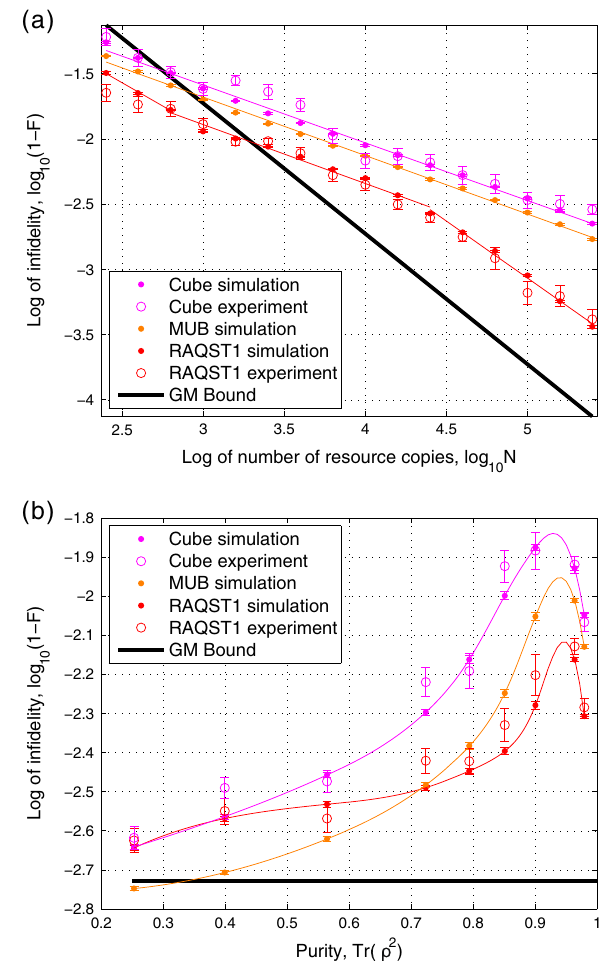
Fig. 4 Experimental results. a In fi delity vs. N . Dots are the average in fi delity of simulation results with 1000 repetitive runs of RAQST1 ( red ), MUB ( khaki ) and standard cube measurements ( magenta ), and circles are the corresponding average in fi delity of 10 repetitive experimental results. Error bars are the standard deviation of the average. b In fi delity with respect to purity for N = 10 4 . Simulation ( dots ) and experimental ( circles ) results are the average of 1000 and 40 repetitions,